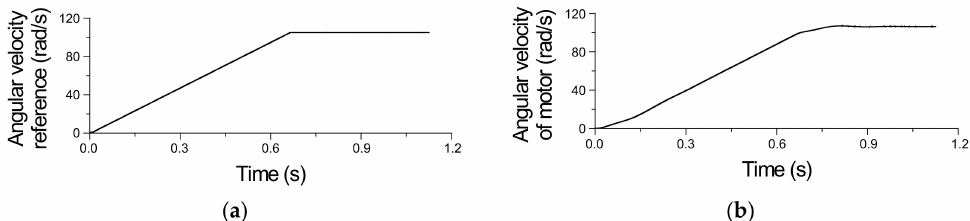
Figure 16. Waveforms of the angular velocity reference ( a ) and the angular velocity of the motor ( b ) during motor start-up in the system shown in Figure 7 for the 0.056 kg · m 2 moment of inertia of the total mass containing the rotor of the DC generator and the disc installed at the end of the shaft.